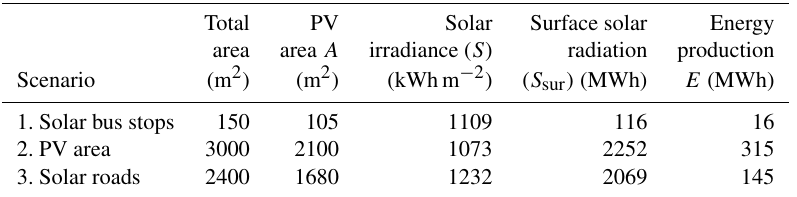
Table 1. Total area used, direct PV area ( A ), total solar irradiance ( S ), total surface solar radiation ( S sur ) and total solar energy production ( E ) during days of operation per year for the three